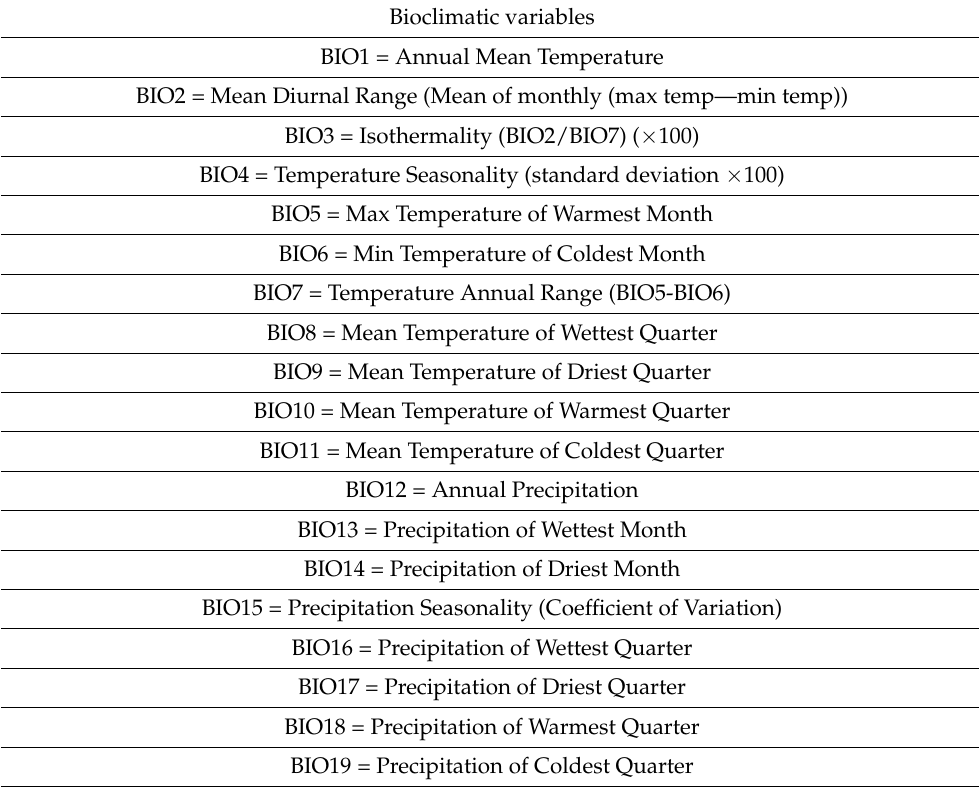
Table A1. Bioclimatic variables.